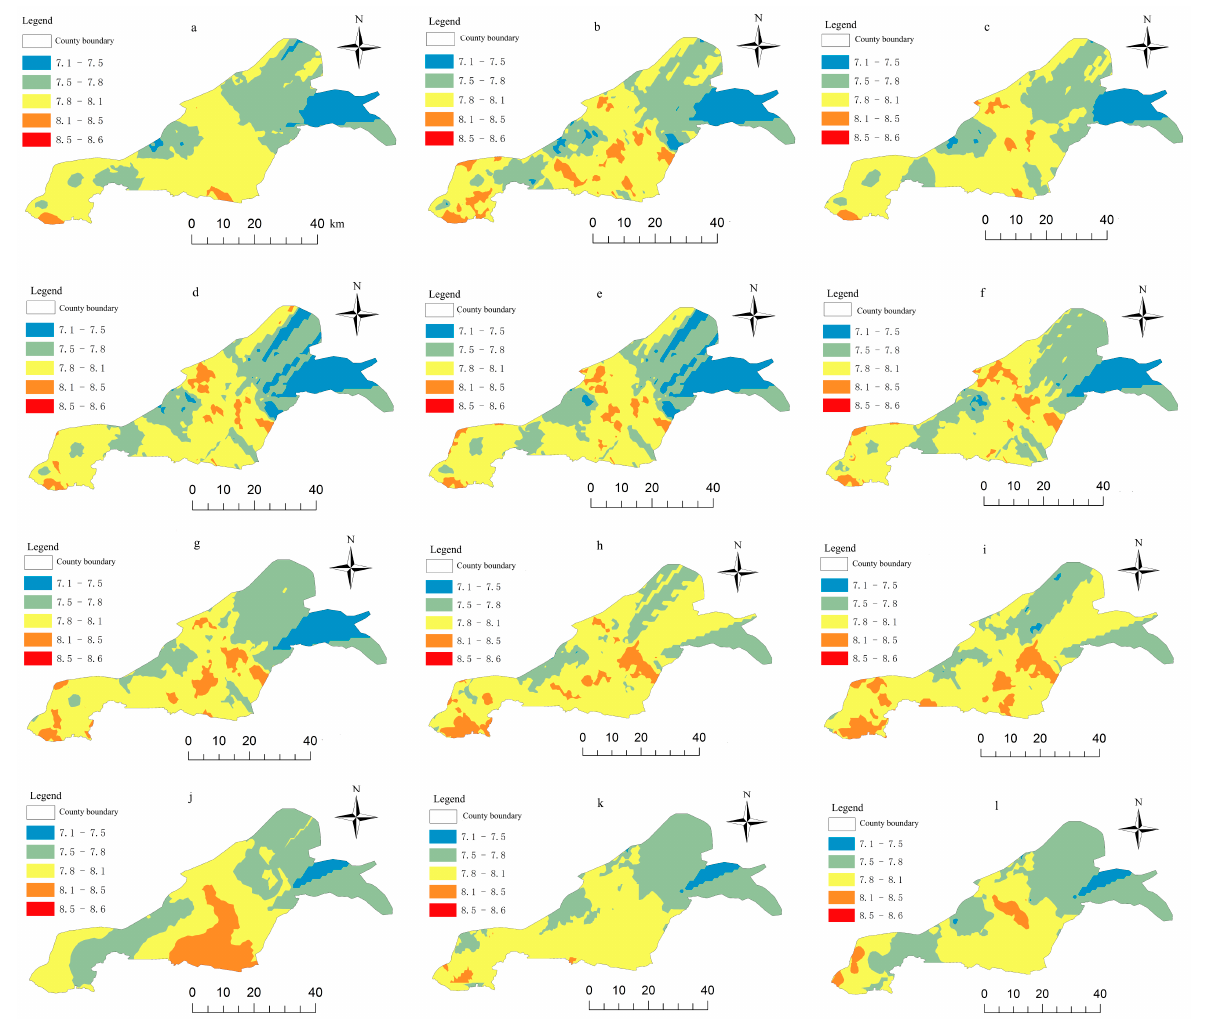
Figure 4. Expression diagram of soil pH spatial variation of different point sets. The letters ( a – l ) represent the spatial variation expression of soil pH at 908, 797, 700, 594, 499, 398, 299, 200, 149, 100, 75 and 50 sampling points respectively. Note: The eastern of Kenli County was not sampled because the area is in the Yellow River Delta National Nature Reserve. However, for the continuity and completeness of maps, the result of the unsampled area was deduced and extended by the Kriging interpolation based on the near sampled